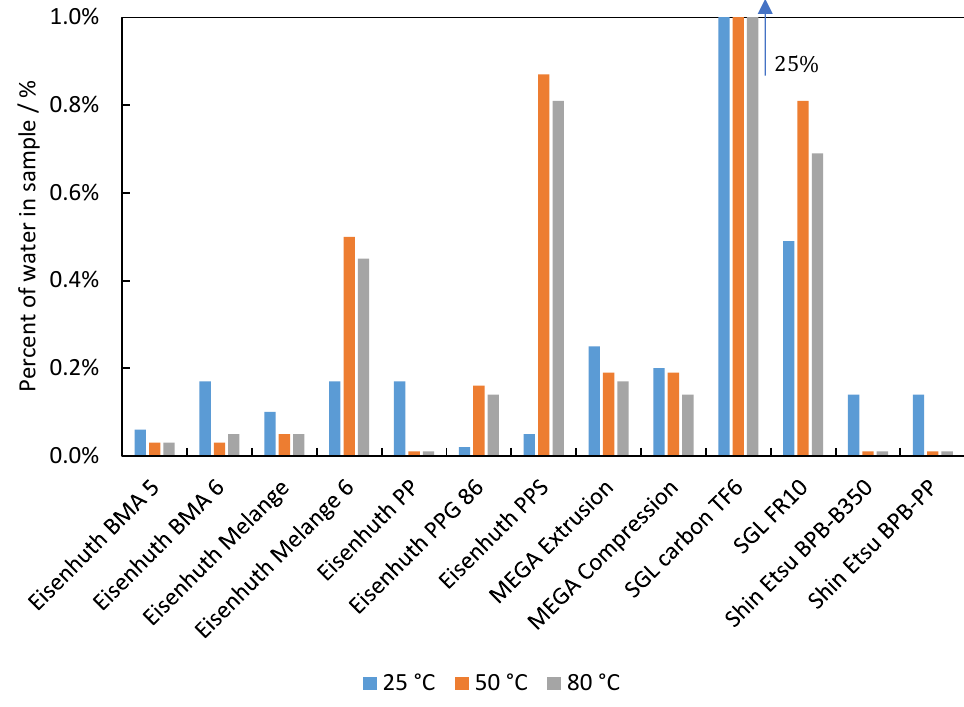
Figure 11. Weight percent of water in the samples after seven days’ swelling at 25, 50, and 80 °C.